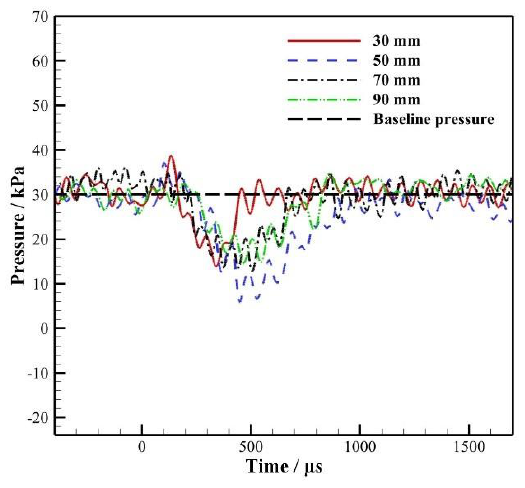
Figure 12. Change curves of ramp pressure with different ramp distances.